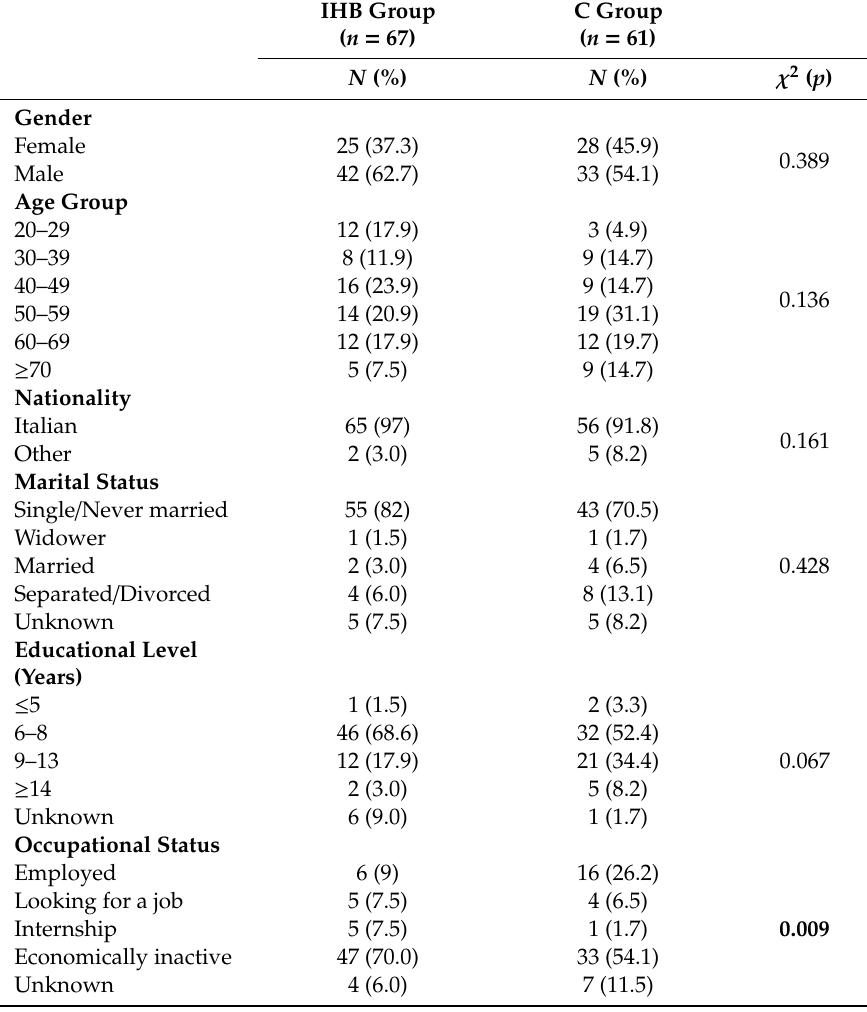
Table 1. Sociodemographic and clinical characteristics of the Individual Health Budget (IHB) and comparator group. Significant p -values at the χ 2 and T -test are highlighted in bold. IHB Group C ( n = 67)